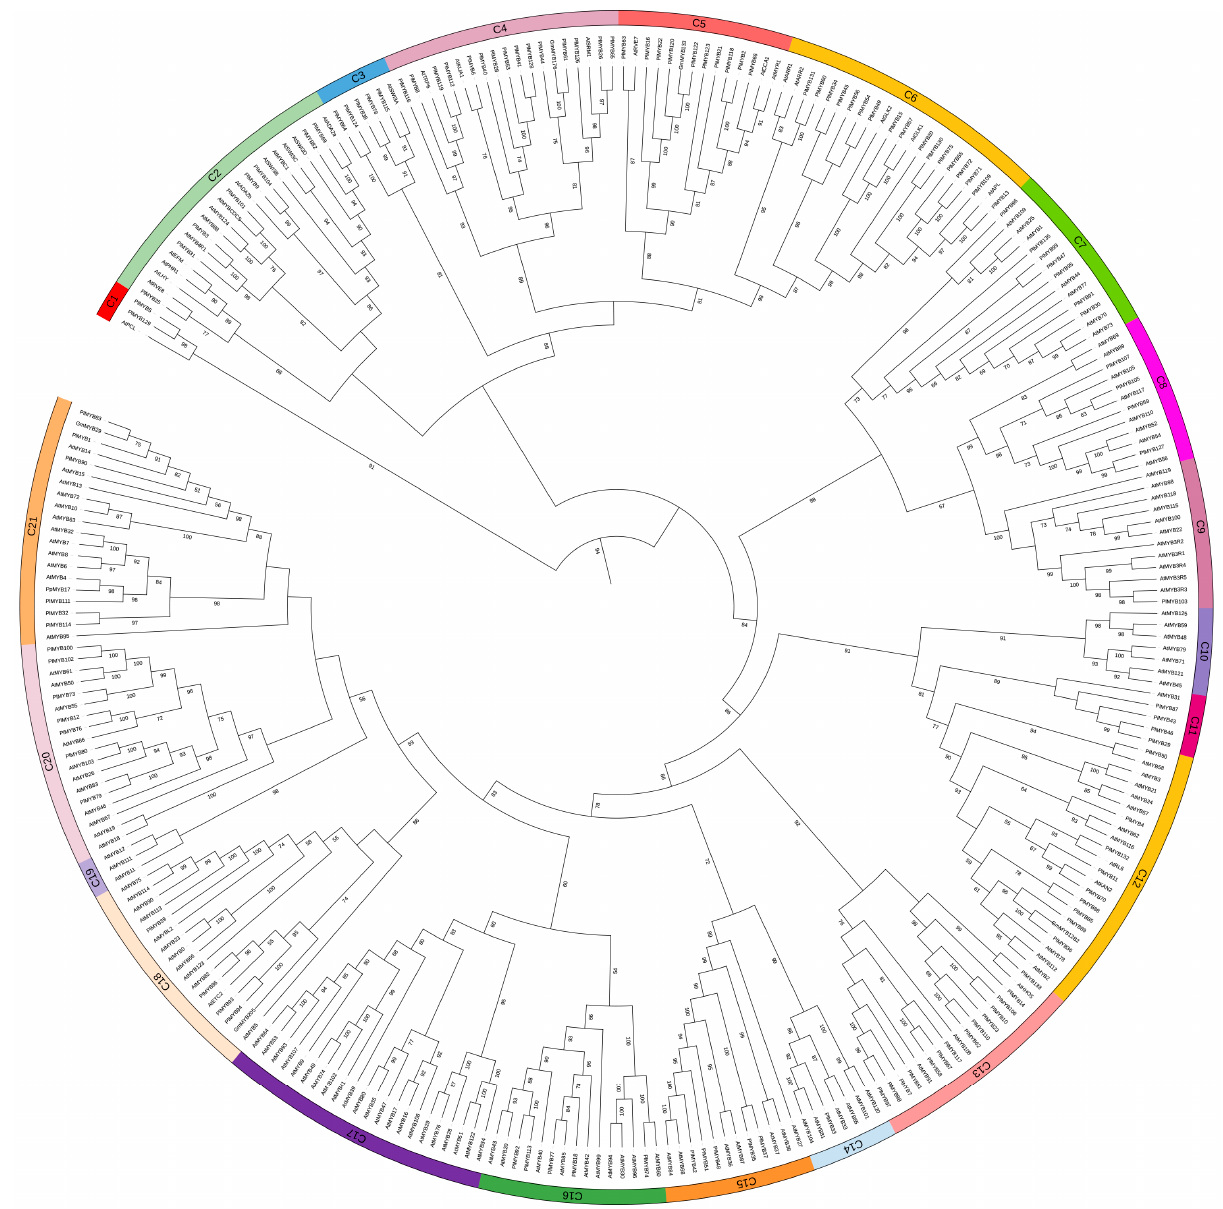
Figure 6. Phylogenetic tree of the 123 P. lobata MYBs with the 161 MYB proteins from Arabidopsis and 6 MYBs from Glycine max . The tree was constructed using the neighbor-joining method using MEGA 6.0 software with 1000 bootstrap replicates. The Arabidopsis MYB proteins used for the tree construction of this study were selected based on a previous report [37].